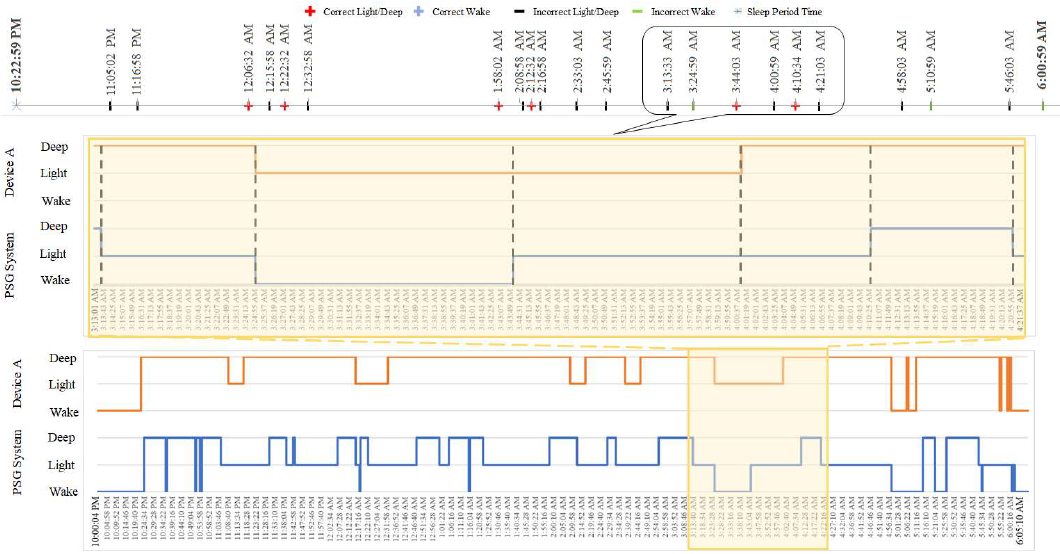
Figure 4. Representative PSG and Device A’s hynograms of a subject with the mismatch from 3:13 to 4:21 a.m.